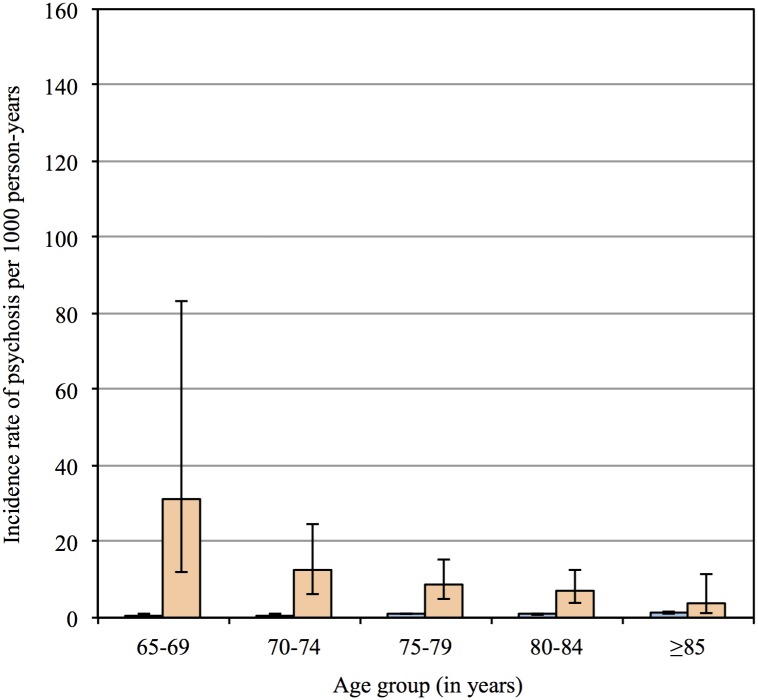
The bars depict the incidence rate of psychotic episode per 1000 person-years for each age group, and the whiskers represent the 95% confidence interval of the rates.The left and right bars for each age group show the results for men without and with Parkinson’s disease respectively.